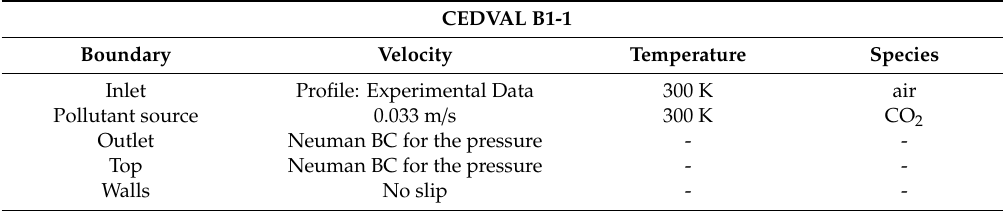
Table 1. Initial and boundaries conditions used for CEDVAL